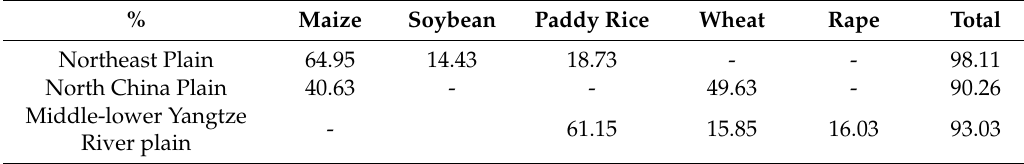
Table 1. Percentage of areas of target crop species sown in different zones in 2015.